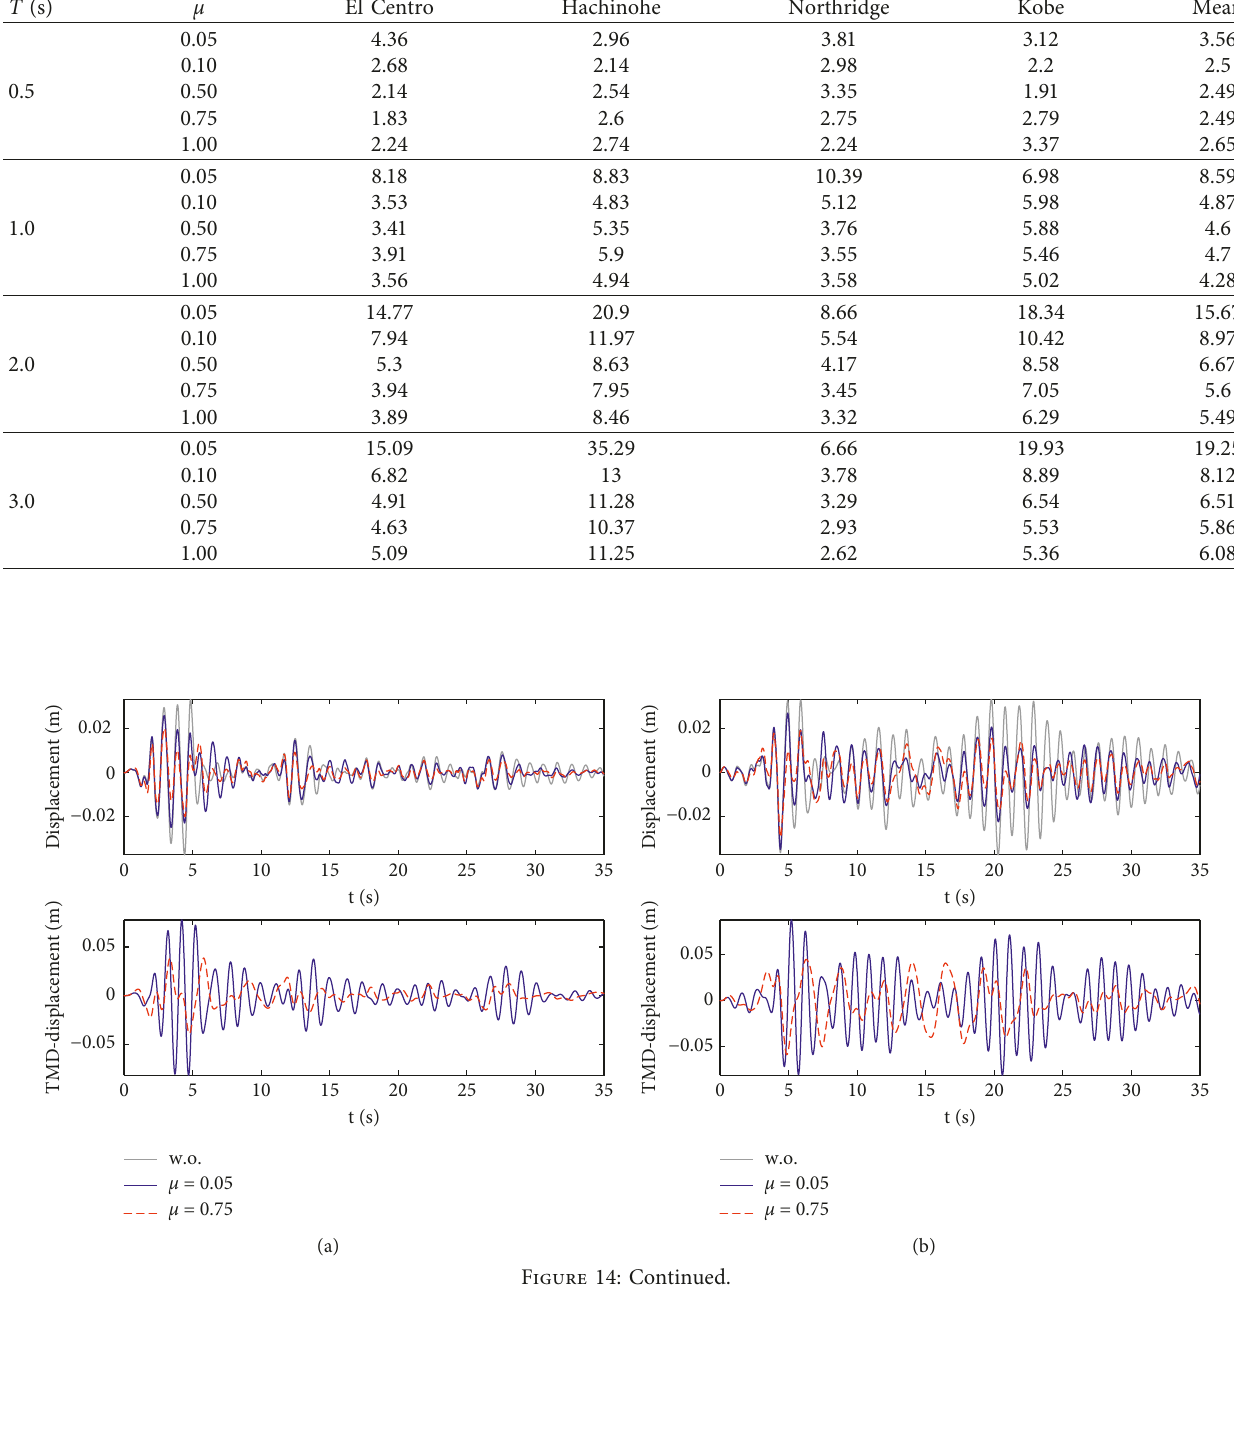
Table 3: Maximum peak value of relative displacement between a TMD with optimal parameters and the main structure (cm). T (s) μ El Centro Hachinohe Northridge Kobe